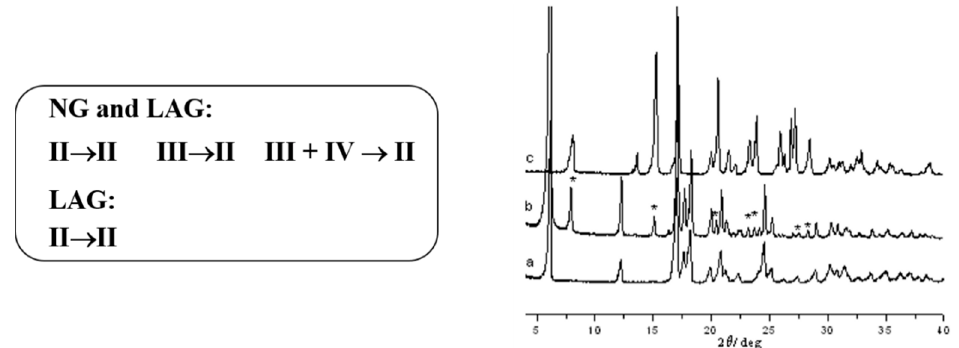
Figure 1. ( left ) Summary of the neat (NG) and liquid assisted grinding (LAG) polymorphic stability experiments; ( right ) XRPD patterns of (a) Form III, (b) Form III after grinding (stars indicate peaks of Form II) and (c) Form III after LAG using ethanol leading to complete conversion into Form II [37].